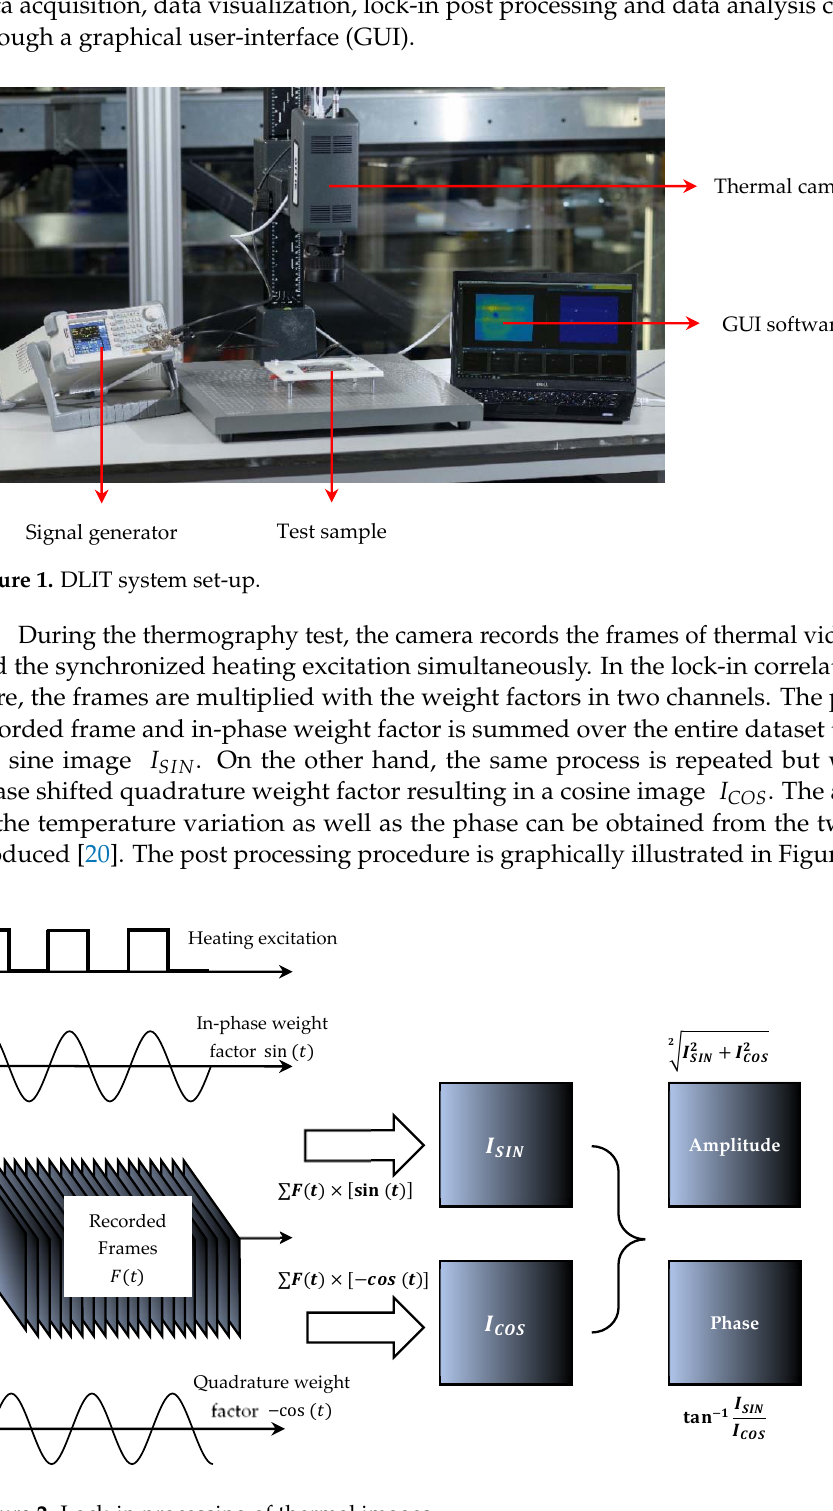
Figure 2. Lock-in processing of thermal images.